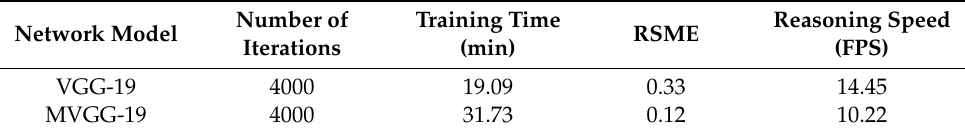
Figure 9. A comparison of model performances: ( a ) loss curve and ( b ) RMSE value. Table 2. Performance comparison of the optimized and original networks.